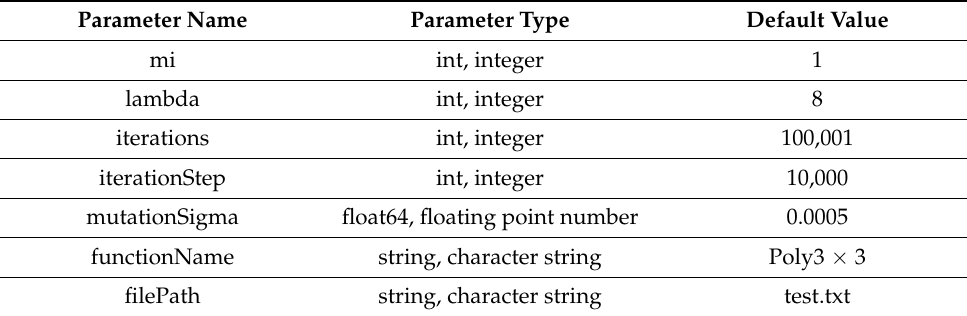
Table 2. Parameters adopted by the